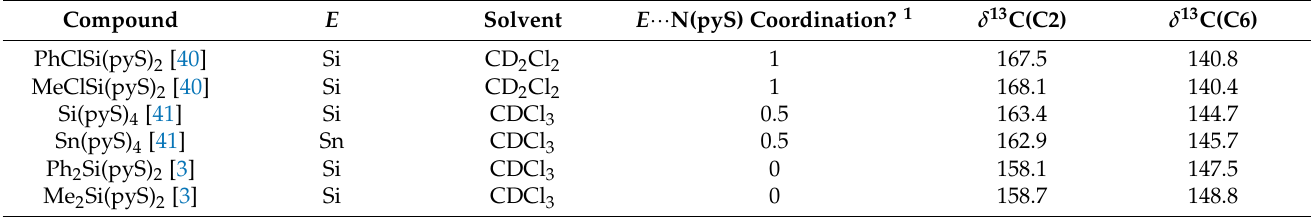
1 For clarity of presentation, groups of corresponding bonds within the set of individual ligands of each molecule were summarized within a block of the same shading. Table A3. 13 C NMR shifts of C 2 and C 6 of the pyridine-2-thiolate (pyS) ligands of a series of related silicon and tin compounds in CDCl 3 or CD 2 Cl 2